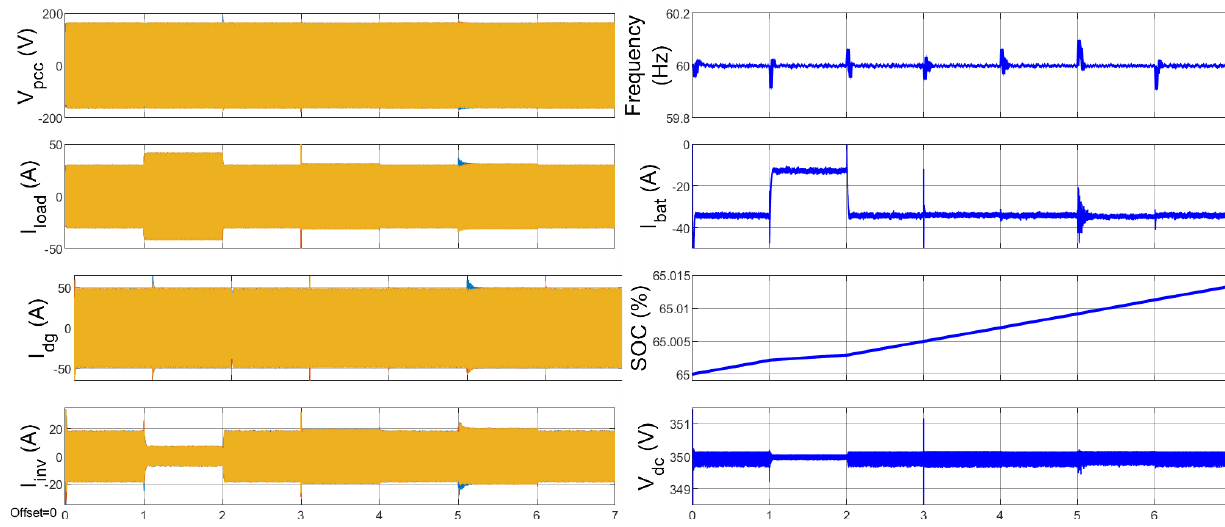
Figure 6. Dynamic performance under load variations.